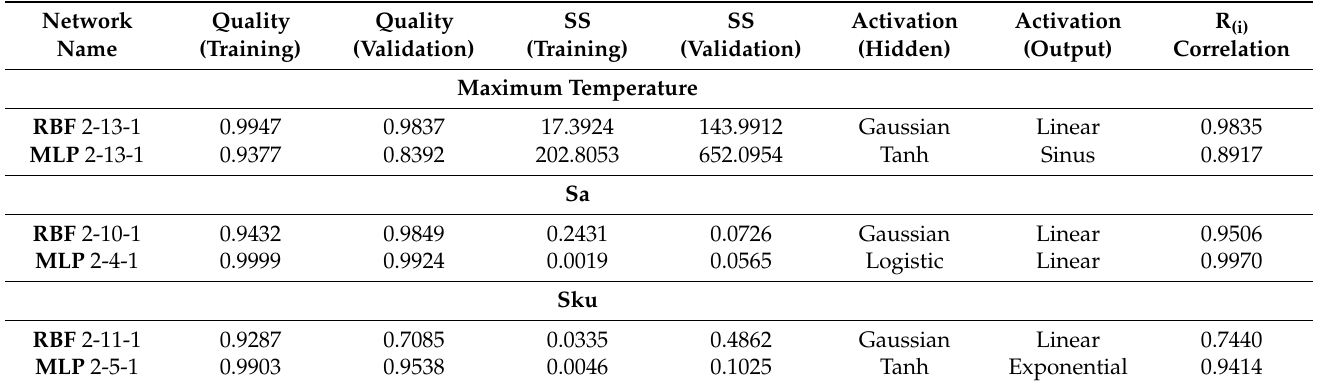
Figure 12. SEM imaging of a magnesium alloy chip surface from the chip flow side on the rake face ( a ) cracks and ( b ) tearing on the free edges. Table 9. Selected networks based on quality (learning, validation), errors (learning,